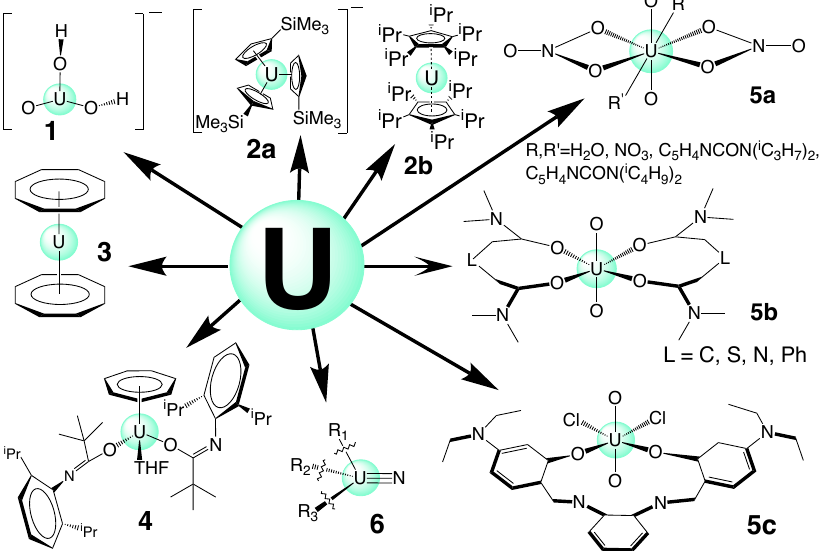
Figure 3. Representative uranium complexes; the numbers refer to the discussion in the